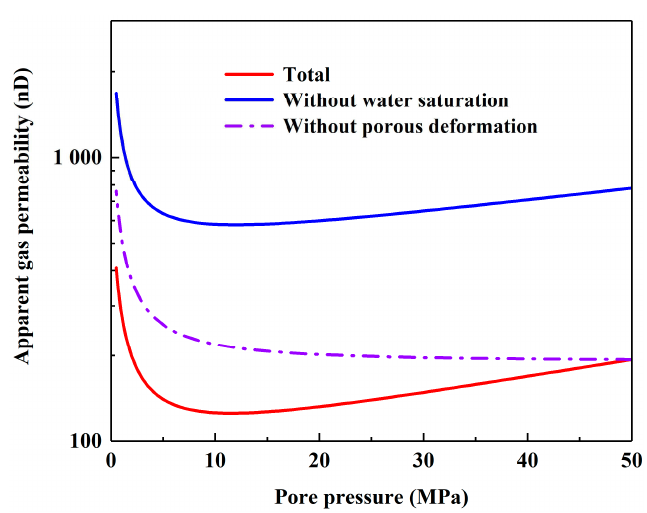
Figure 13. The AGP with different influential effects coupling ( h = 30 nm, S w = 0.3).